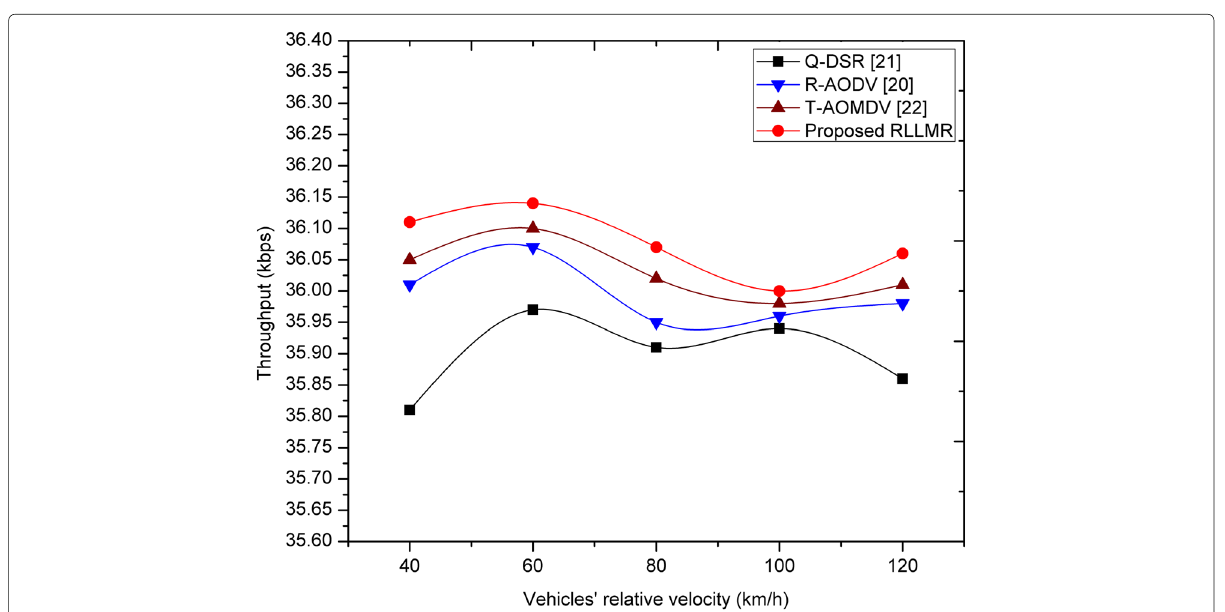
Fig. 14 Effect of different velocities over throughput (nodes 50, R 1000 m, sig 5 km/h, t 10